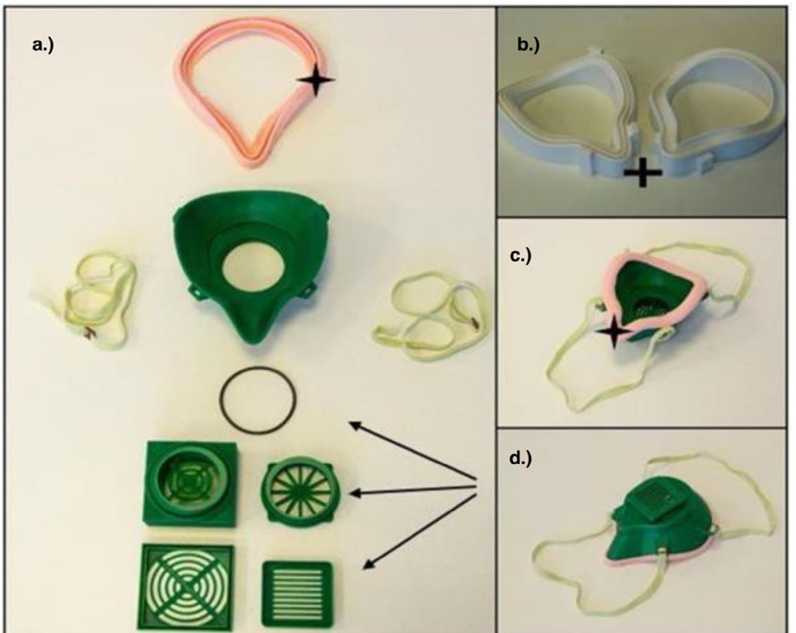
Figure 6. The 3D printed face mask respirator. ( a ) Disassembled face mask respirator. ( b ) Silicone ring layer to promote better face-fitting which had its mold 3D printed. ( c ) Reverse angle of respirator with silicon ring visible. ( d ) Assembled face mask respirator. This image is reprinted under a Creative Commons Attribution 4.0 International License and it is taken from [18].